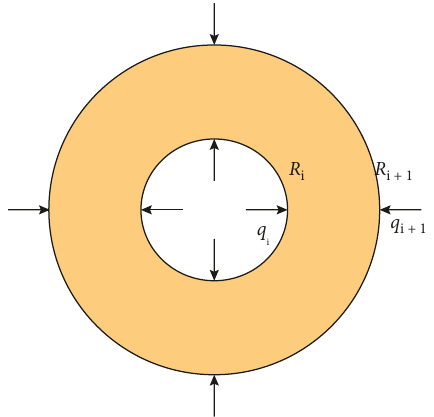
Figure 6: Stress induced by the uniform